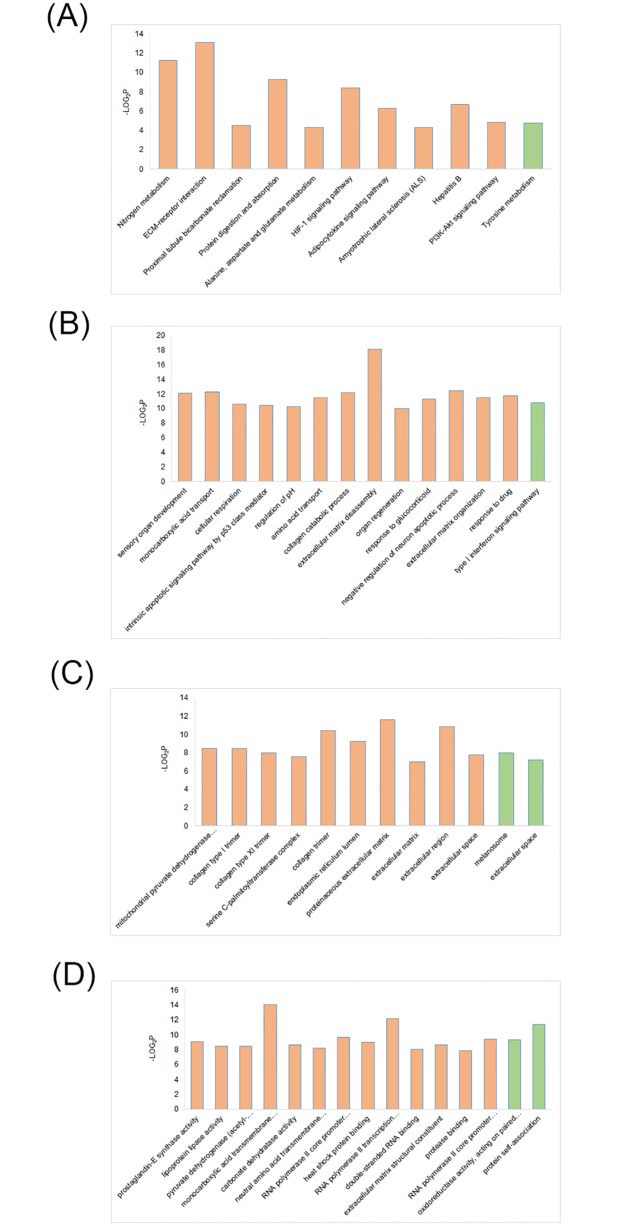
The most significantly altered enriched terms based on GO definitions and KEGG pathway definitions.(A) KEGG pathway terms. (B) GO BP terms. (C) GO CC terms. (D) GO MF terms. Yellow columns: significant in high concentration group; green columns: significant in high concentration group.